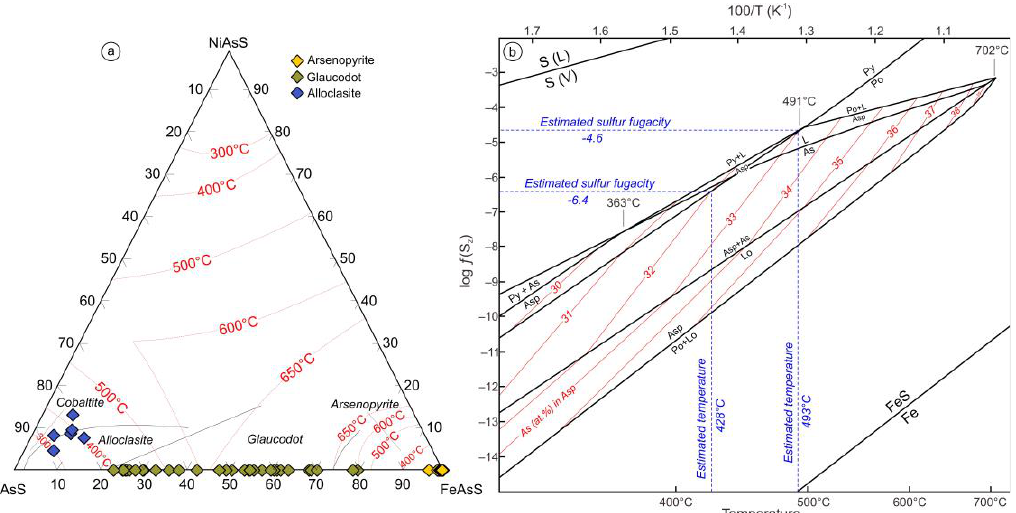
Figure 10. ( a ) Ternary diagram of Co-Ni-Fe-sulfoarsenides that shows three different minerals found in the Ruwai skarn deposit with their estimated ore-forming temperature (diagram modified [33 – 35]); ( b ) estimated temperature and sulfur fugacity during ore formation in the Ruwai skarn deposit based on as content in arsenopyrite (diagram modified after